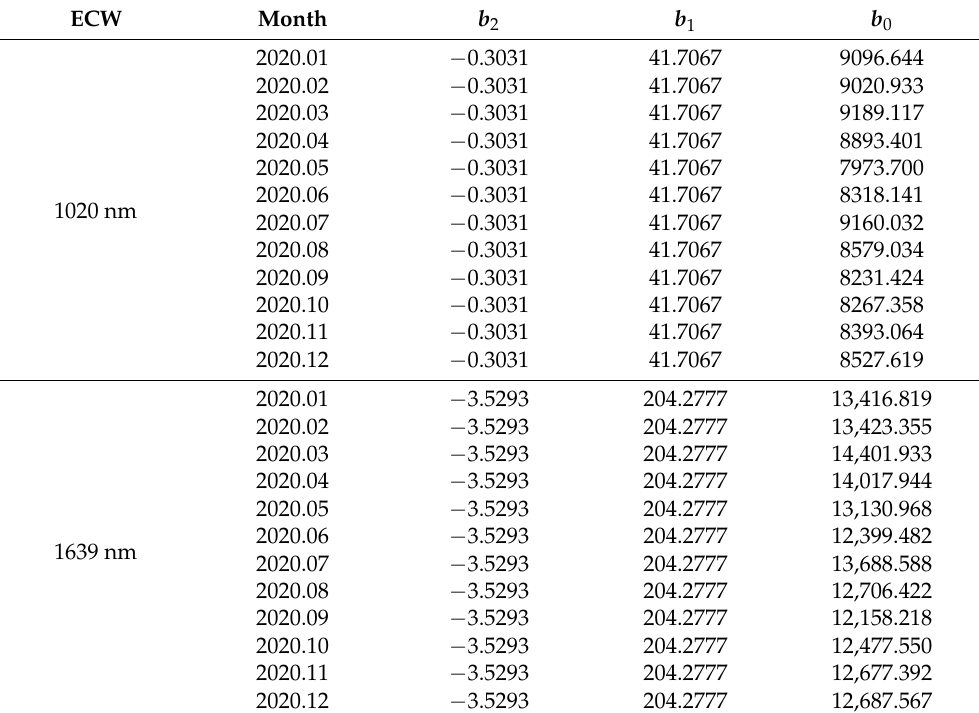
b and b were fixed to 2 1